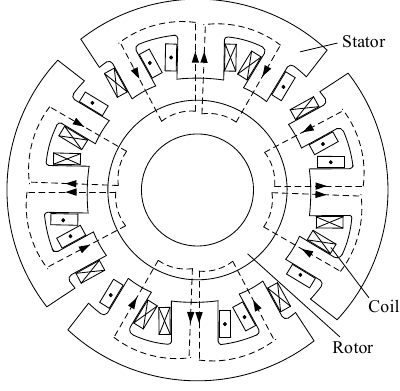
Figure 7. The 12-pole RMB E-type Figure 7. The 12 ‐ pole RMB E ‐ type structure.